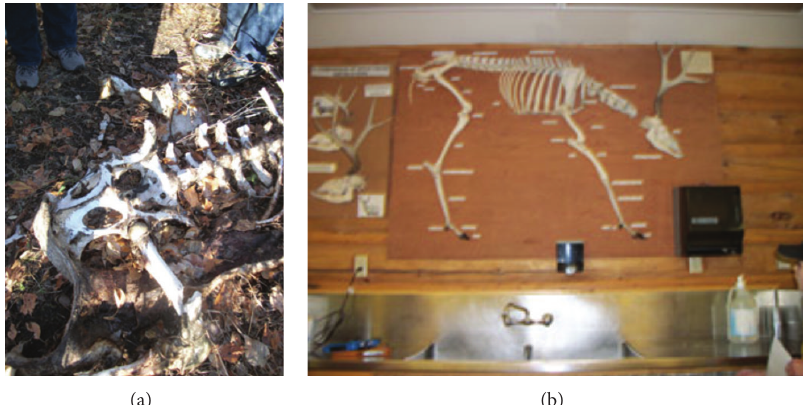
Figure 2: A comparison of animal skeleton photographs taken (a) during an outdoor activity and (b) within a museum space at the host facility. Students’ reflections, as obtained in the interviews, are provided. (a) And this you can see, it is cracked right there, and you can see the fur, and you can see the hip bone, but there was two rib cages . . . this one was not entirely broken so we (my friends and I) are guessing that this one had stronger bones, and we are guessing it was a bison, and we are guessing this one is a moose or an elk, and we think a wolf went after these two. Student 13 And this is a picture of an animal, I think it is probably like a ... I do not know . . . but it is bigger than me. Student 11.